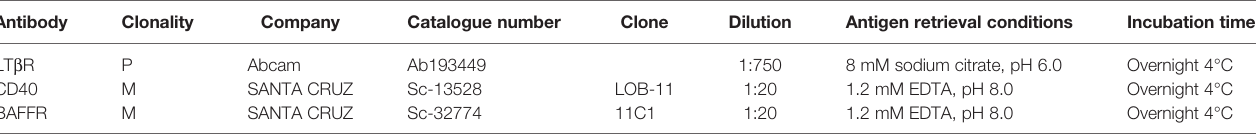
TABLE 5 | Primary antibodies and their clonality, clone, dilution, antigen retrieval, and incubation time information.